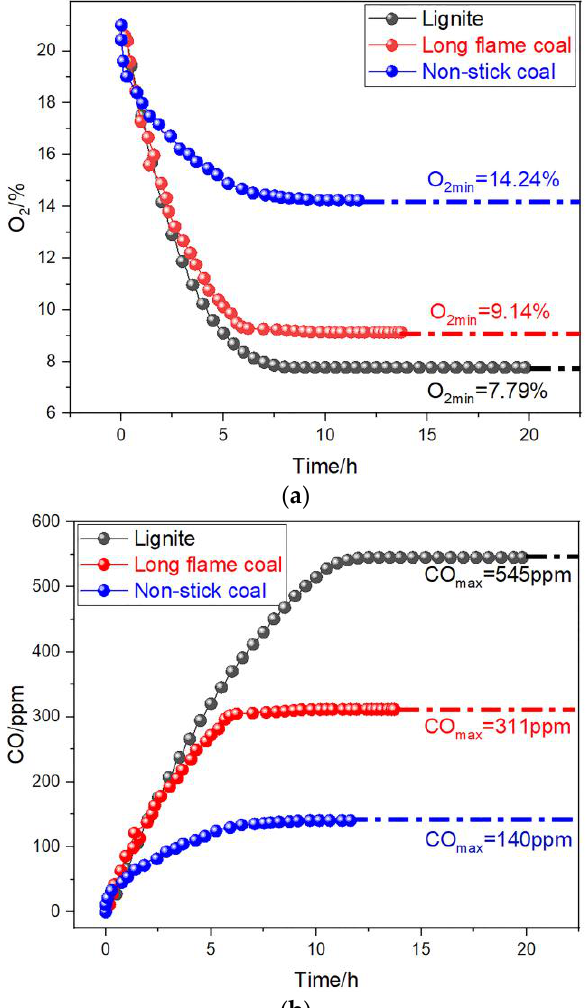
Figure 4. (a) O 2 . (b) CO. Variation in O 2 and CO concentration with time. Figure 4. ( a ) O 2 . ( b ) CO. Variation in O 2 and CO concentration with